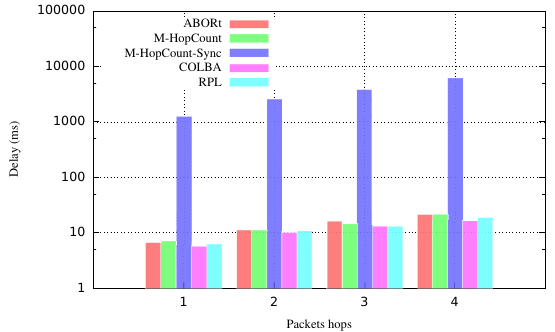
Figure 8. End-to-end delay per hop for 1 pkt/sec/node.